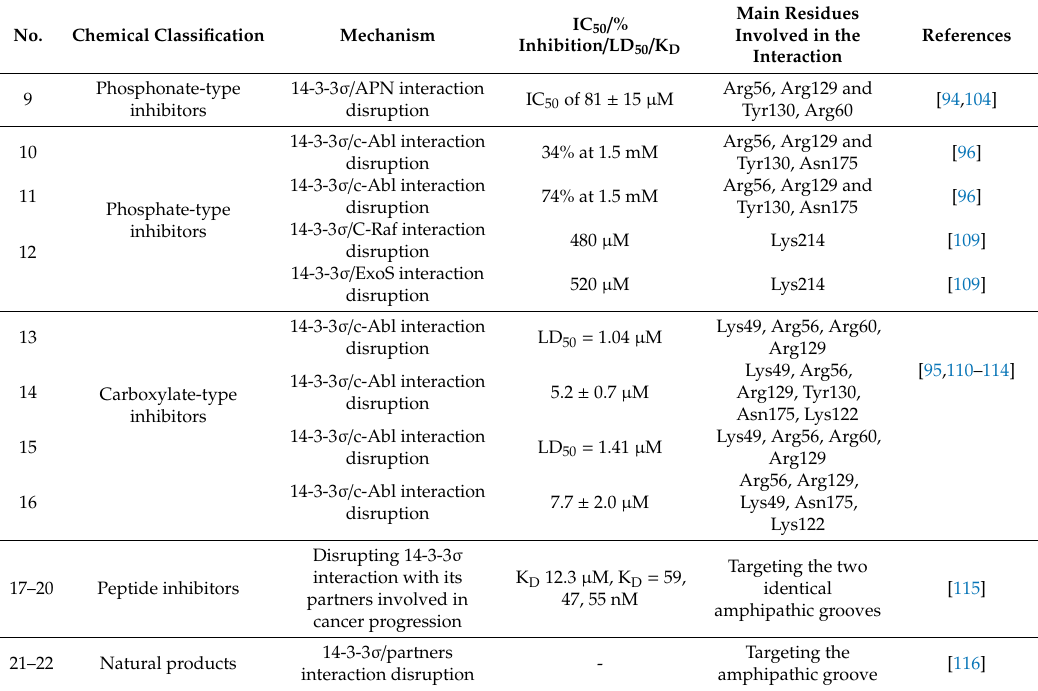
Table 1. Comparison between di ff erent types of 14-3-3 σ